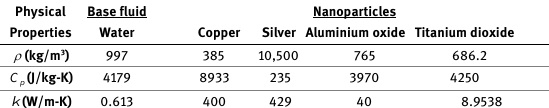
Table 2: Comparison of- θ (cid:48) (0) with distinct value of Pr for λ = 0